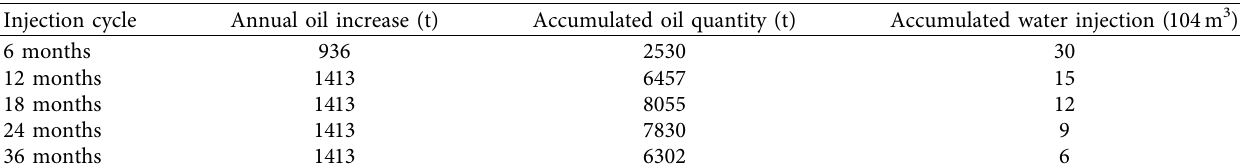
Table 5: Comparative data table of pressure flooding effect in different injection cycles.